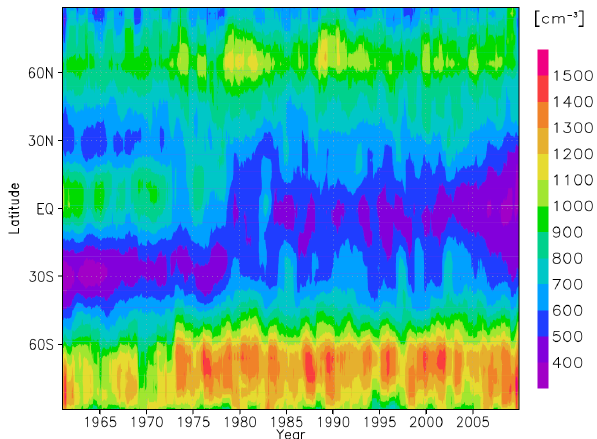
Figure 15. Annual sliding average of mean nighttime number den- sity of OH ∗ at height of v = 6